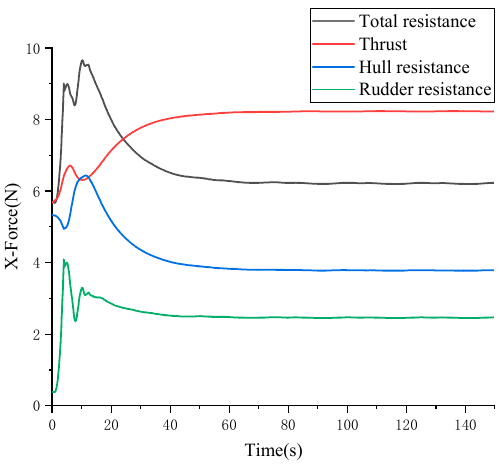
Figure 12. Force in +35° X direction.